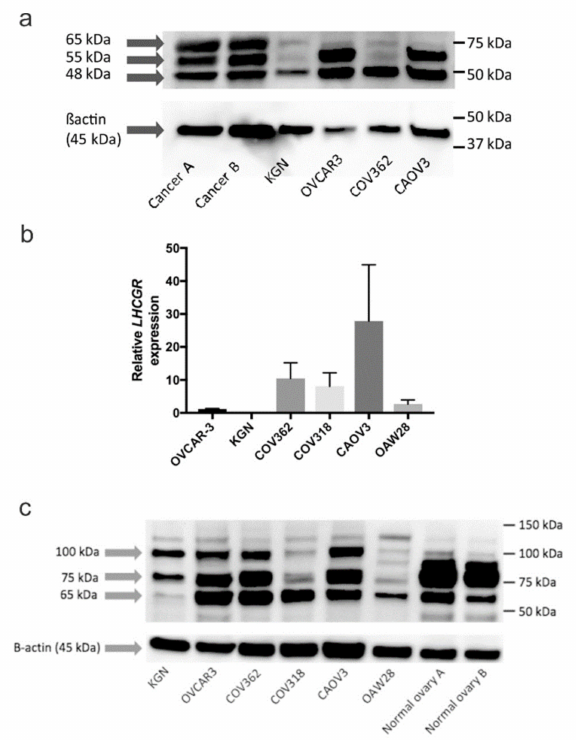
Figure 9. Follicle-stimulating hormone receptor (FSHR) and luteinising hormone receptor (LHCGR) expression in serous ovarian cancer cell lines. ( a ) Protein extracts from cell lines (~40 µ g) and high-grade ovarian cancer tissues (~5 µ g) were electrophoresed and immunoblotted with FSHR H-190 (1/400, Santa Cruz) antibody and β -actin (1/2000, Abcam, Cambridge, MA, USA) was used as a loading control. Bands were detected at ~48 kDa, ~55 kDa and ~65 kDa. ( b ) LHCGR mRNA expression in ovarian cancer cell lines using quantitative real-time PCR. Relative expression was normalised to the house keeping gene β -actin using the 2 − ∆∆ CT method. Data is expressed as the mean ± SEM from three individual RNA samples obtained from 2 independent experiments. ( c ) Protein extracts from cell lines (~40 µ g) and normal ovaries (~5 µ g) were electrophoresed and immunoblotted with LHCGR antibody (LS-C3345991/1000, LifeSpan Biosciences, Seattle, WA, USA) antibody and β -actin (1/2000, Abcam) was used as a loading control. Major bands were detected at ~65 kDa, ~75 kDa and ~100